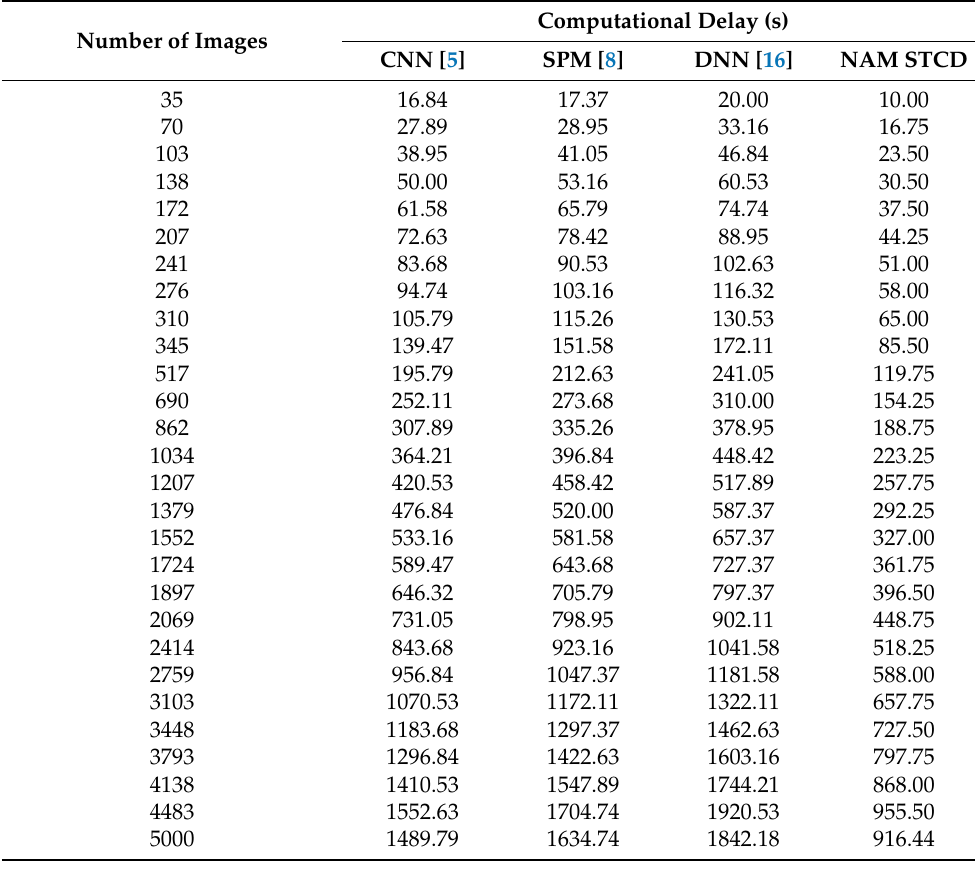
Table 4. Computational delay of different models.